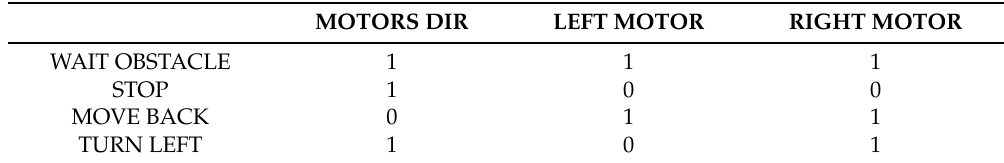
Table 2. Values for FSM output signals in each state. MOTORS DIR LEFT MOTOR RIGHT